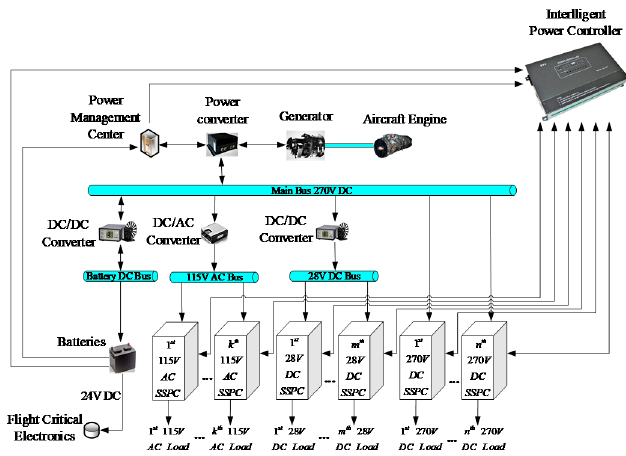
Figure 1. A Solid-State Power Controller (SSPC)-based aircraft power distribution system (PDS).